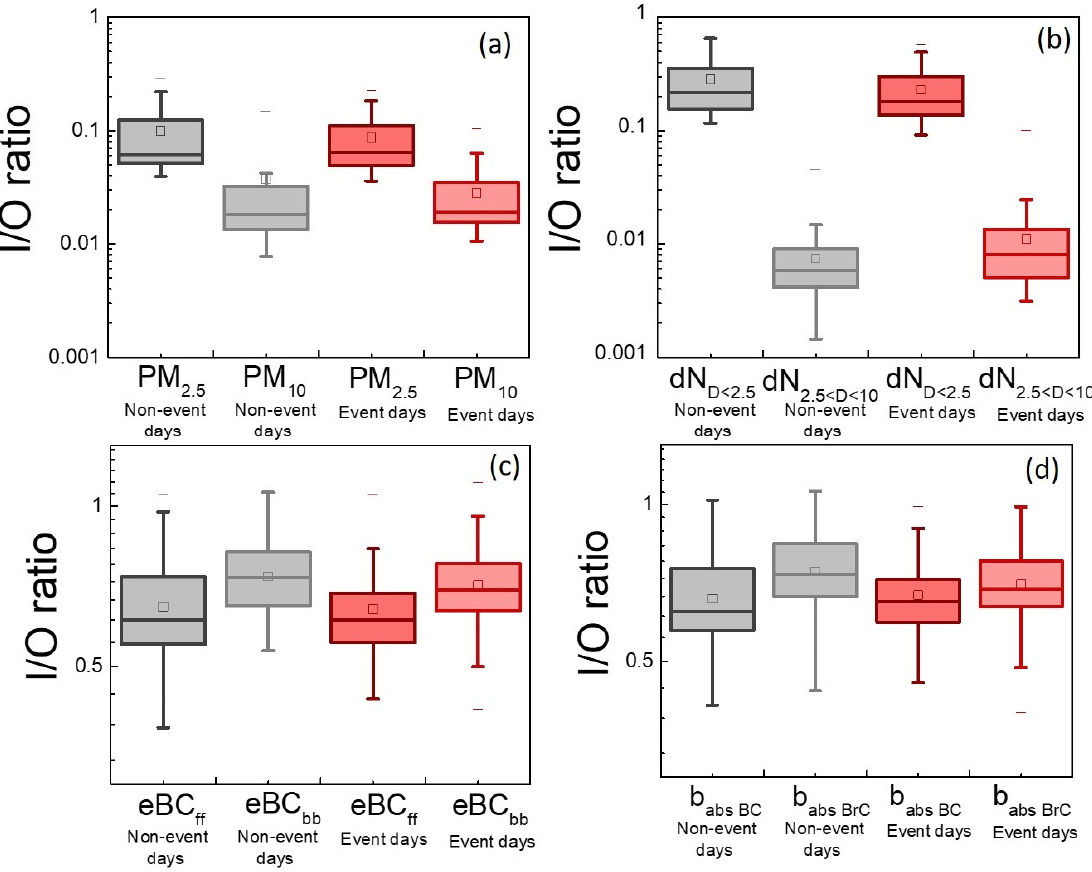
Figure 8. Box charts of indoor/outdoor (I/O) ratios of PM 2.5 and PM 10 ( a ), particle number concentration of big (dN 2.5<D<10 ) and smaller particles (dN D<2.5 ) ( b ), eBC ff and eBC bb ( c ), b abs eBC and b abs BrC ( d ) during event and non-event days in indoor and outdoor air.